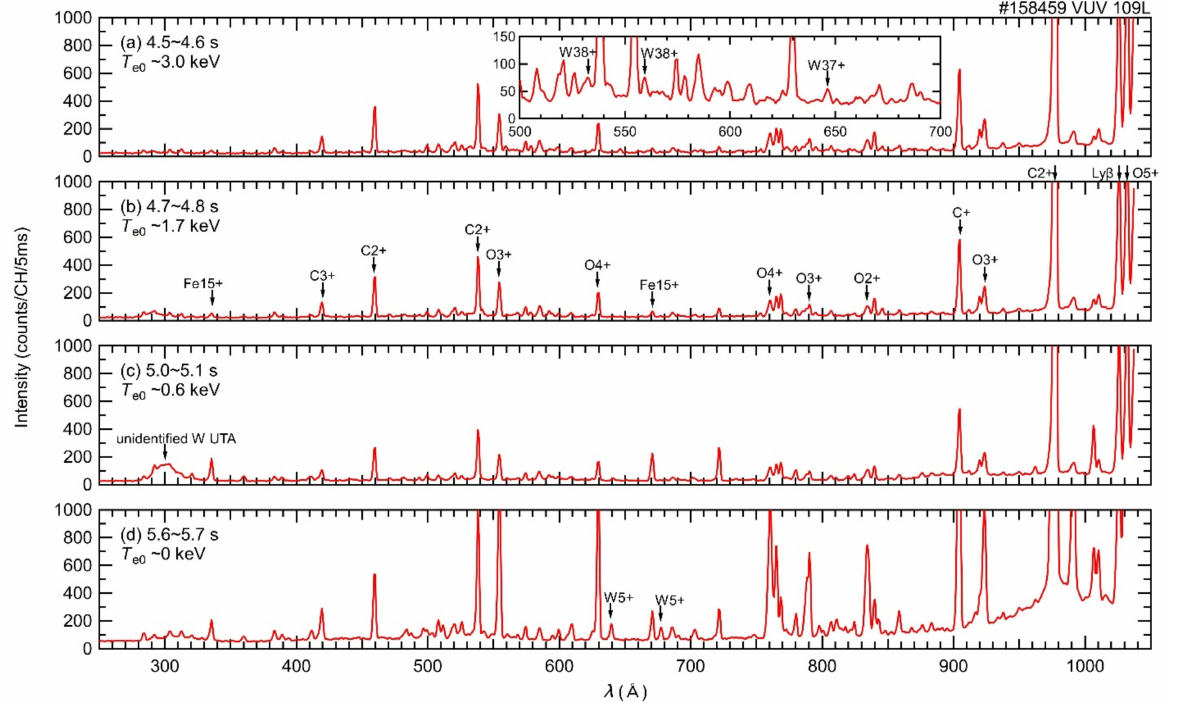
Figure 5. VUV spectra including W 5+ , W 37+ , and W 38+ line emissions in the wavelength range of 250–1050 Å measured using “VUV 109L” spectrometer with T e 0 for each timing of data acquisition. ( a ) 4.5~4.6 s, T e 0 ~3.0 keV, ( b ) 4.7~4.8 s, T e 0 ~1.7 keV, ( c ) 5.0~5.1 s, T e 0 ~0.6 keV, ( d ) 5.6~5.7 s, T e 0 ~0